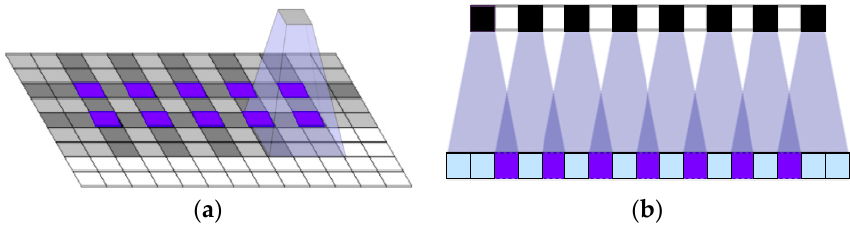
Figure 5. Schematic illustrating an artifact caused by the transposed convolution: ( a ) checkerboard problem caused by applying a transpose convolution; ( b ) uneven overlap (with the parameters of stride 2 and size 3). stride 2 and size